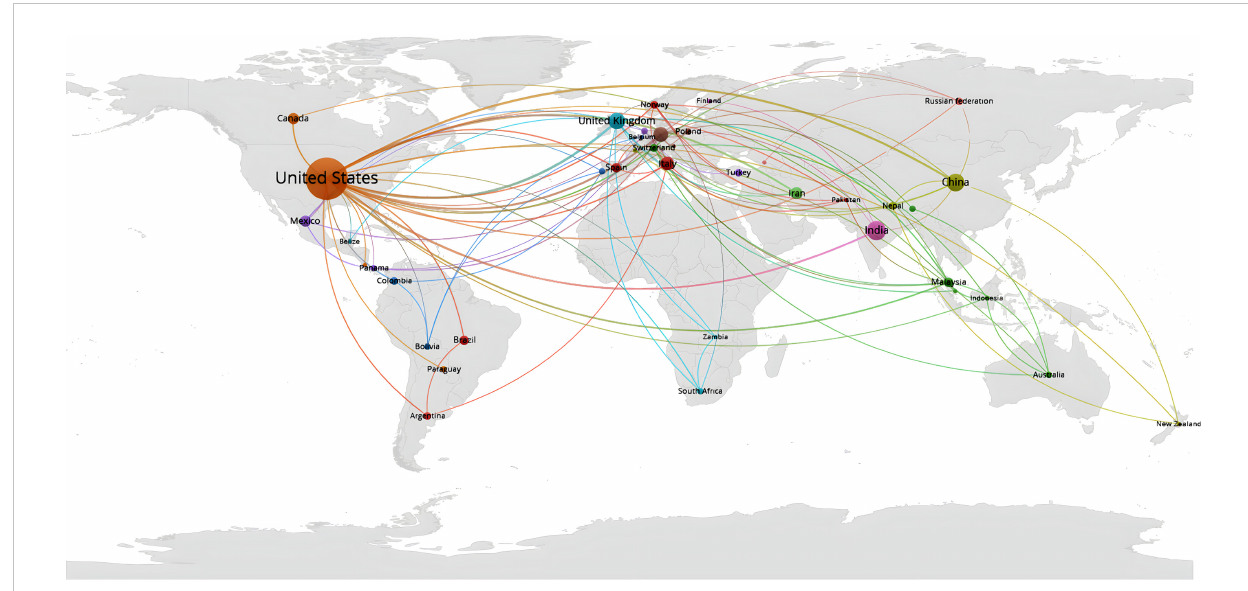
FIGURE 7 Global research collaboration (co-authorship) for large carnivore corridor research, including studies on both the identi fi cation and the use of the corridors. From: VOSviewer doi: